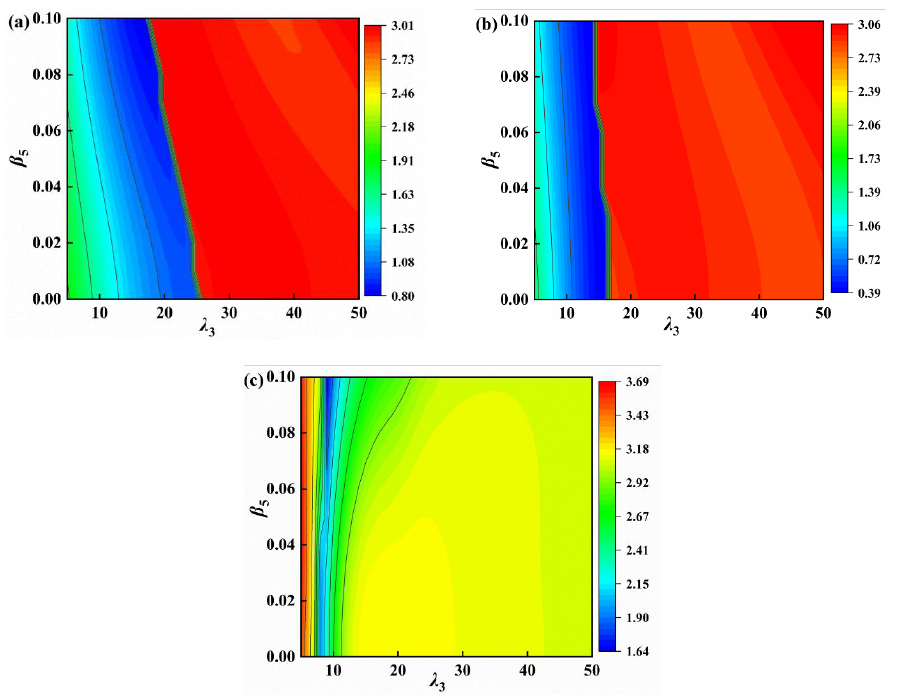
Figure 8. The maximum displacement RMS of the primary structure as the negative stiffness ratio β 5 and inertance ratio λ 3 under f e = 0.4 mm: ( a ) β 3 = 0.0027; ( b ) β 3 = 0.027; ( c ) β 3 = 0.27.